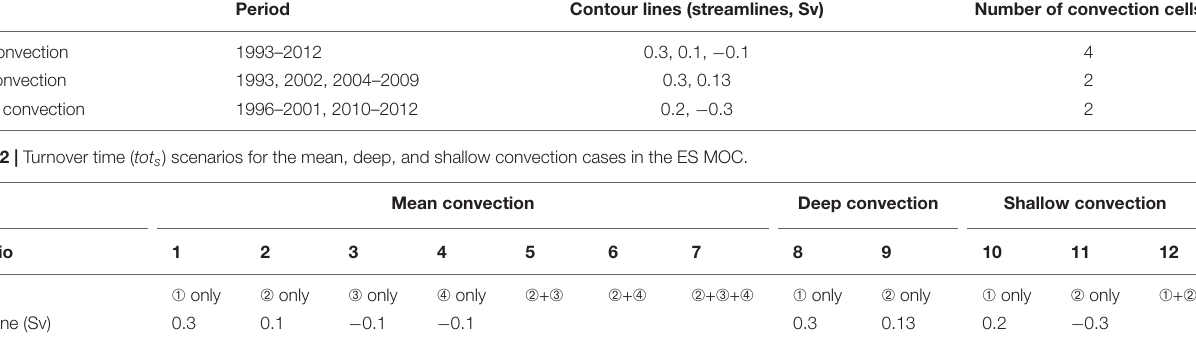
TABLE 1 | Cells characteristics in the three ES MOC cases. Case